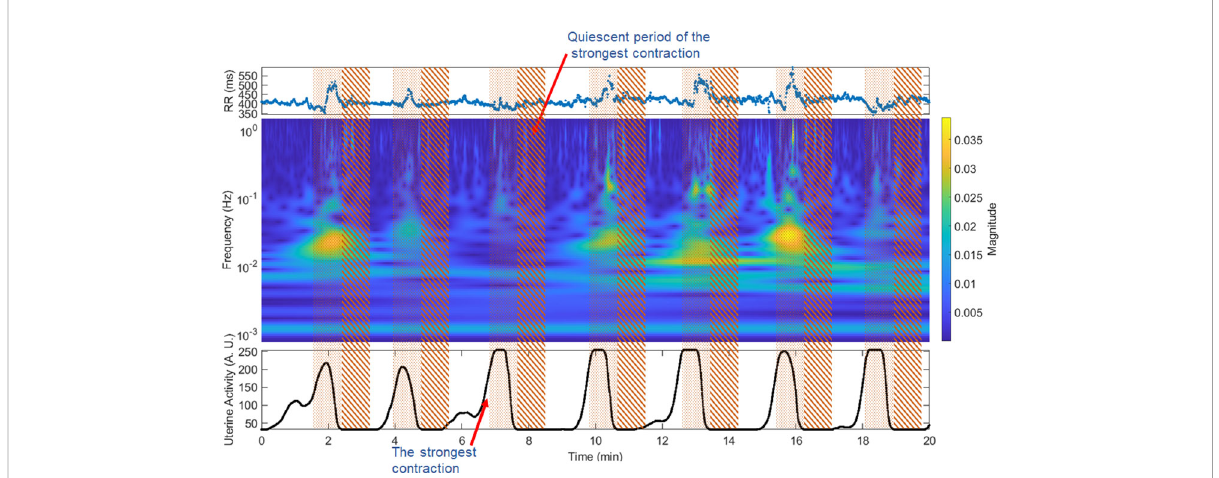
FIGURE 1 Window segmentation of 50 seconds for the fetal R-R signal and time-frequency representation. Pointed area: contraction period, striped area: quiescent interval. The upper panel shows the fetal beat-to-beat R-R time series; the middle panel shows the time-frequency representation of the fetal R-R time series; the lower panel shows the TOCO-like